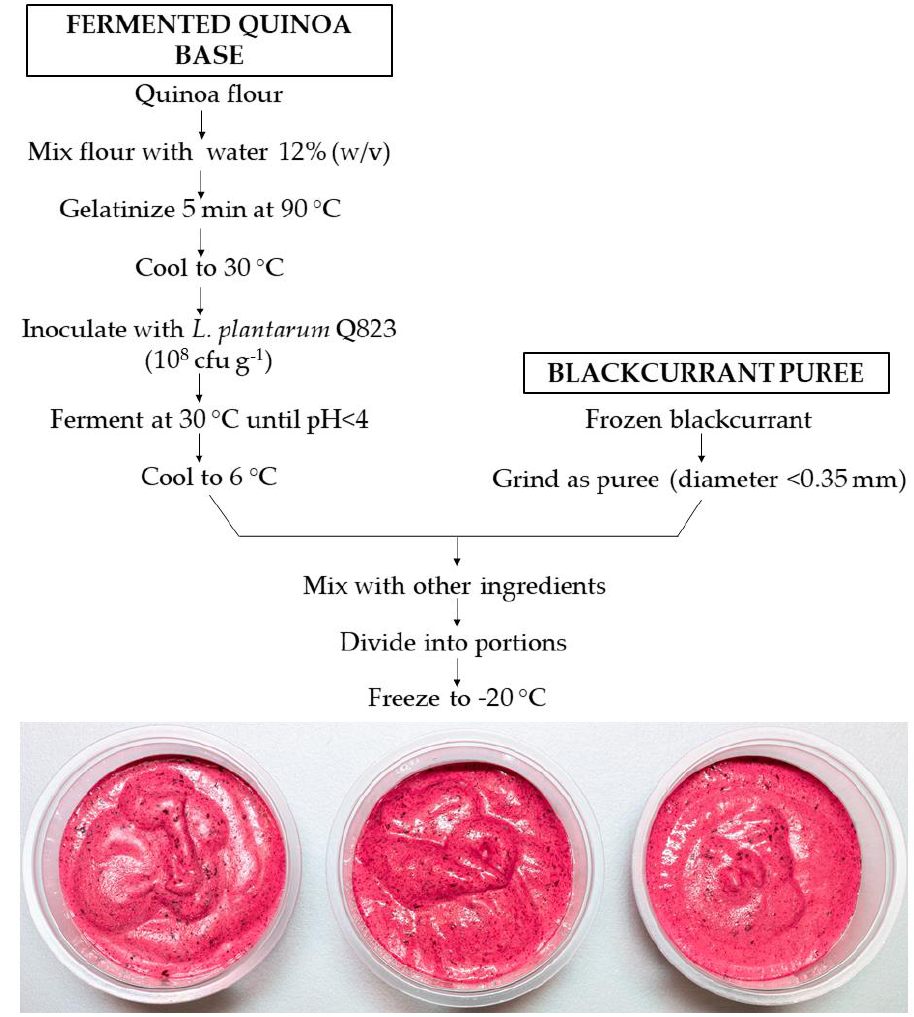
Figure 1. The manufacturing process of frozen blackcurrant products.